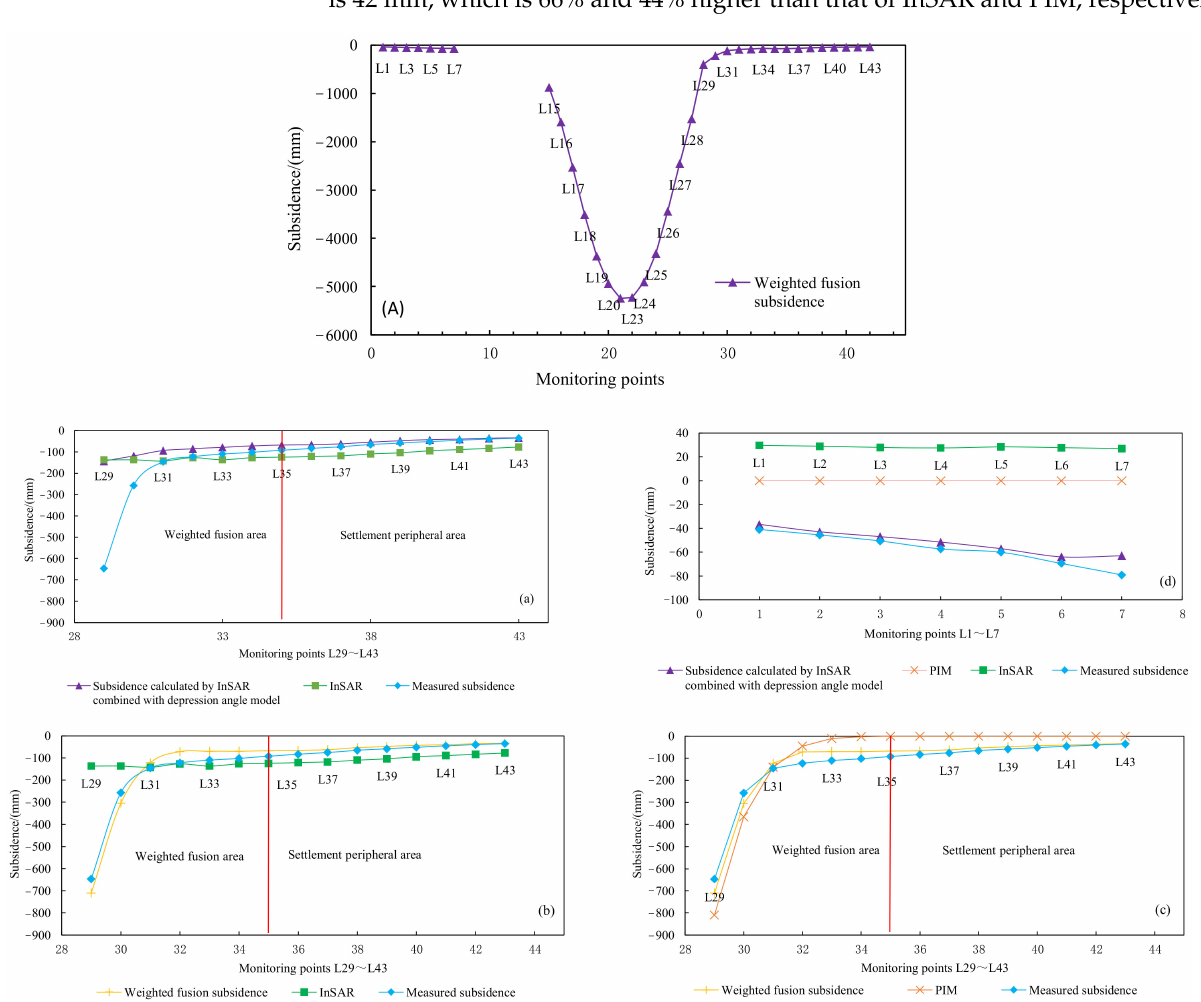
Figure 20. Comparison of monitoring results. ( A ) Monitoring results of dip main section. ( a – c ) Comparisons of monitoring results from L 29 to L 43 by different methods. ( d ) Comparisons of monitoring results from L 1 to L 7